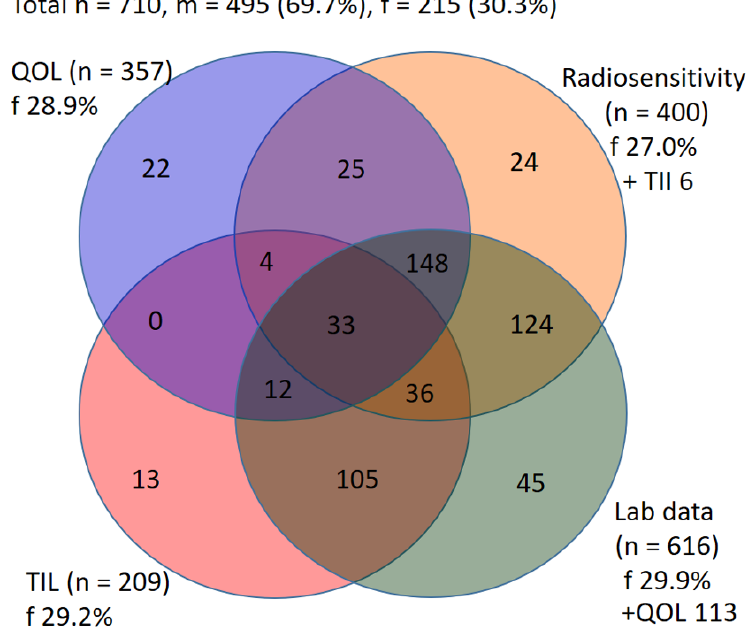
Figure 1. Members of the cohort from four subgroups. The number in the four overlapping circles indicates the number of participants from all four subgroups, corresponding to the three, two and single subgroups. The numbers “+TIL” stand for the intersection of the patient numbers from the radiosensitivity group and the TIL group or “+QOL” for the intersection of the QOL group and the laboratory data group. m = male, f = female, QOL = quality of life cohort, TIL = tumor-infiltrating lymphocytes cohort.